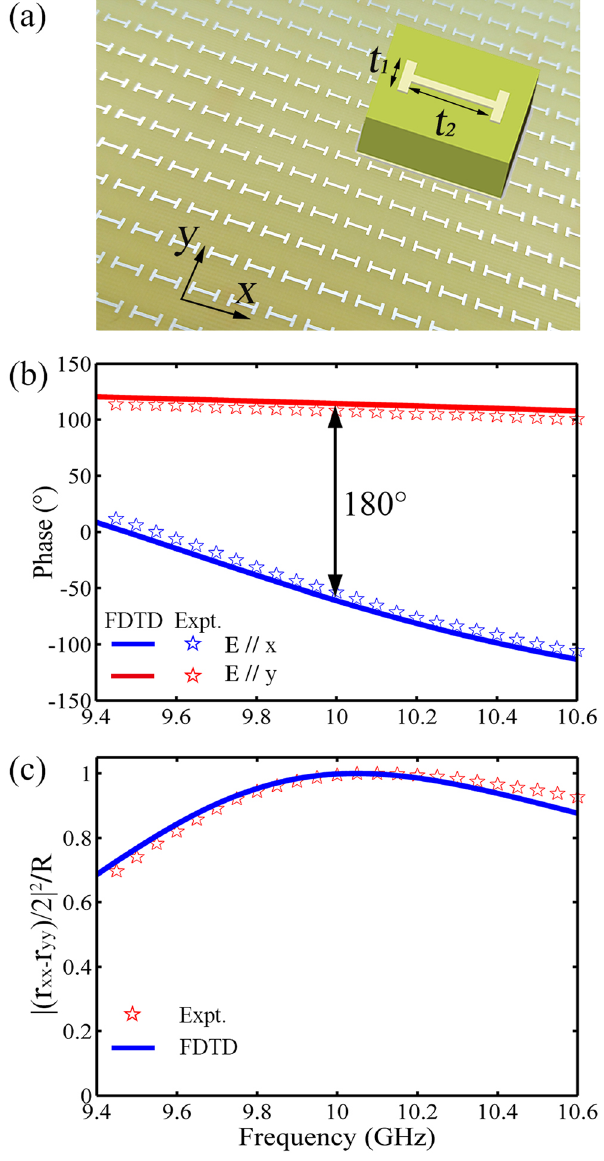
Figure 2. Designs of the high-efficiency PB meta-atom. ( a ) Picture of the PB meta-atoms composed by the symmetrical metallic H structure (sized 7 × 7 mm 2 ) array and a flat metal mirror separated by a 2 mm thick dielectric spacer with t 1 = 2.2 mm, t 2 = 4 mm. ( b ) Co-polarization reflection phase of φ x , x (blue) and φ y , y (red) as a function of frequency for the sample shown in ( a ) illuminated respectively by x and y polarized wave. ( c ) Estimated PW-SW conversion efficiency based on the formula |( r xx − r yy )/2| 2 / R for the sample shown in ( a ) illuminated by CP wave. Here, the results are obtained by both FDTD simulations (solid line) and far-field experiments (open stars). The thickness of the dielectric spacer is 2 mm and the width of the metallic wire is 0.5